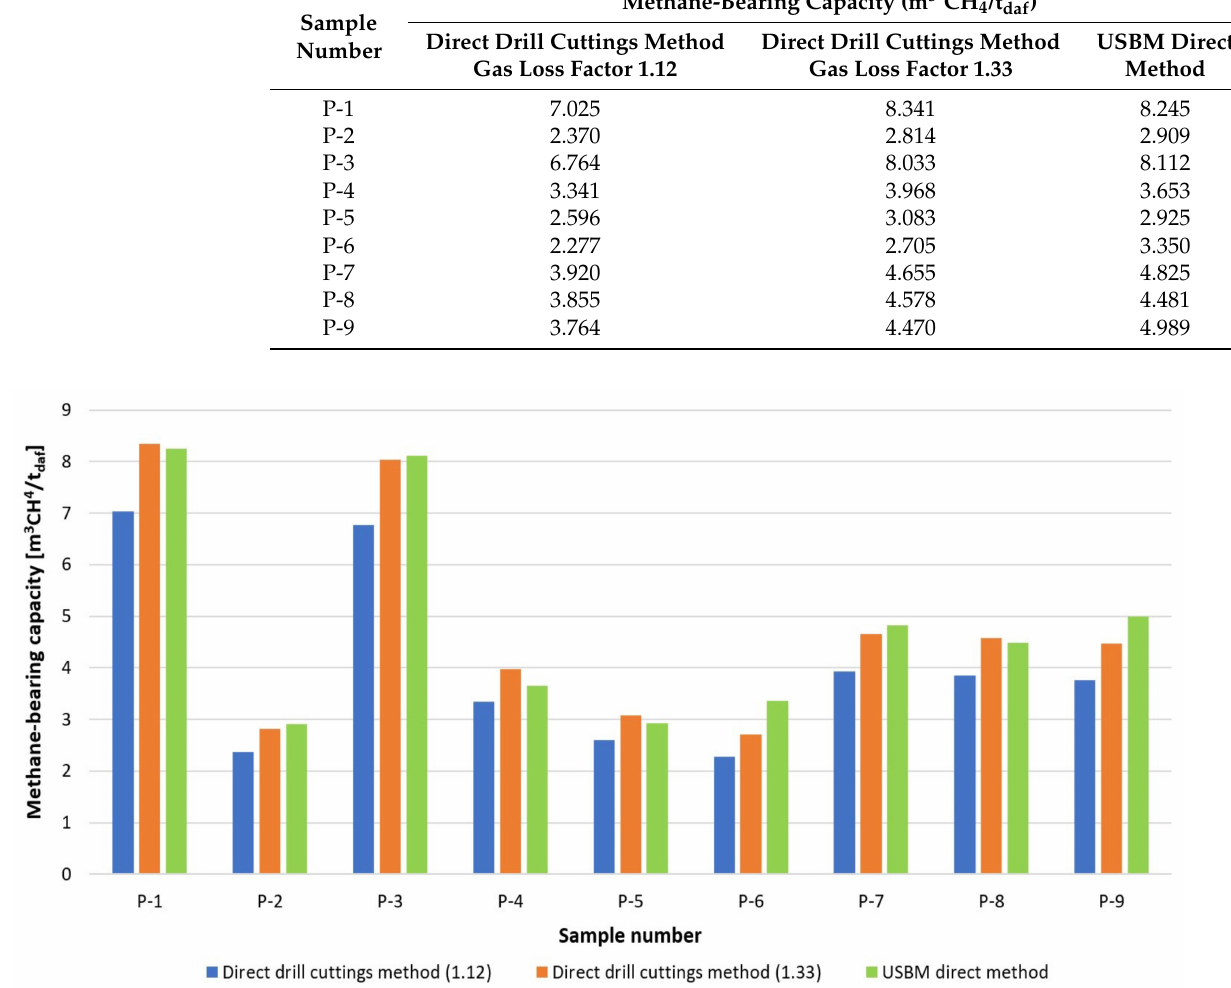
Figure 7. Graphical summary of methane-bearing capacity test results obtained using the USBM method and the direct drill cuttings method with a loss factor of 1.12 and